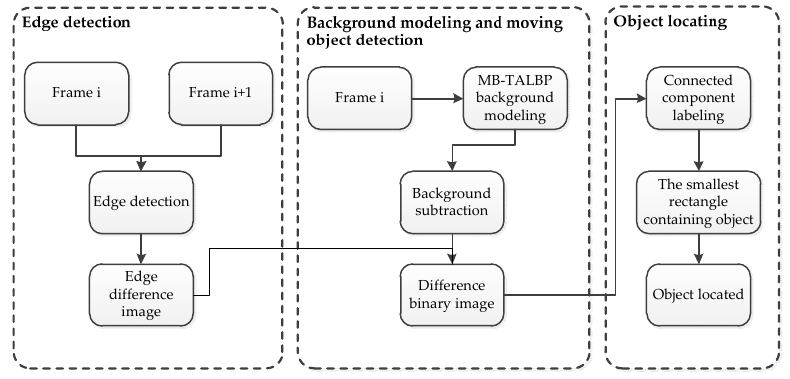
Figure 1. The flow chart of the proposed scheme.